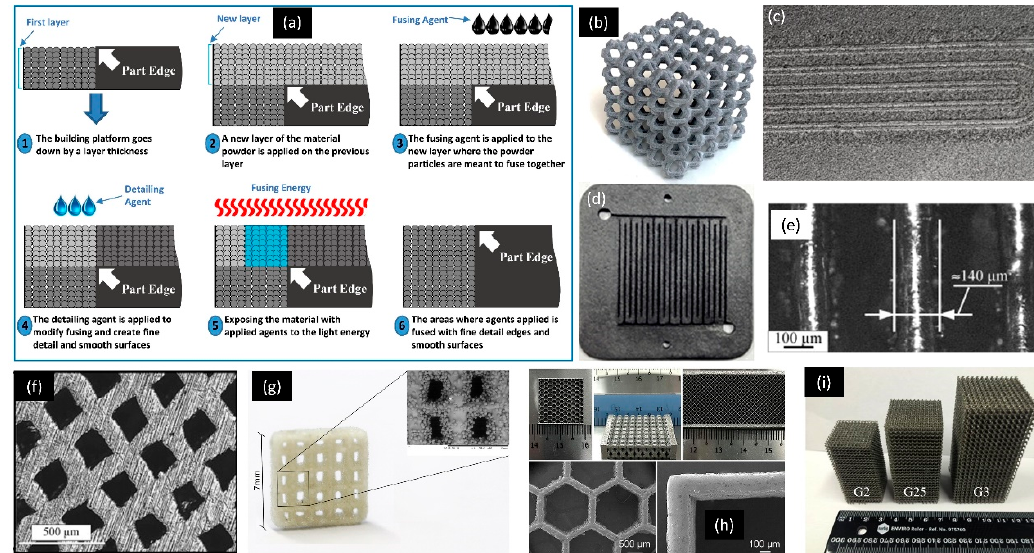
Figure 4. Concept of MJF 3D printing and example of PBF 3D-printed parts. ( a )